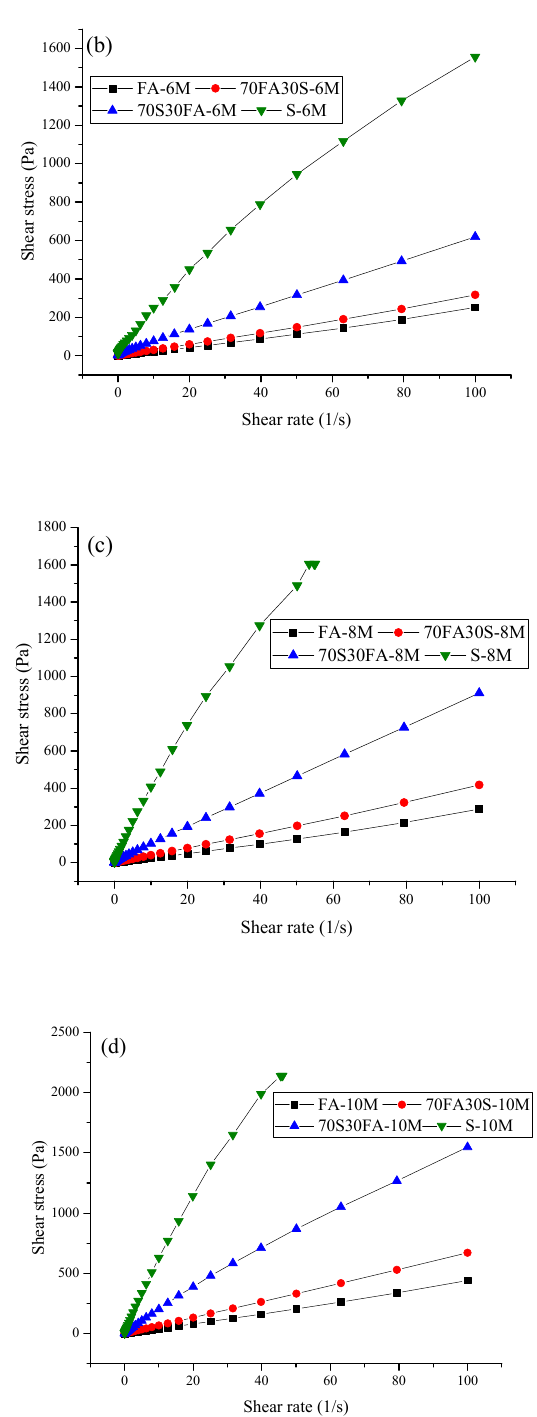
Figure 1. Flow curves for alkali-activated mixes: NaOH molarity of ( a ) 4 M, ( b ) 6 M, ( c ) 8 M, and ( d ) 10 M. Table 2. Yield stress and plastic viscosity of alkali-activated mixes.